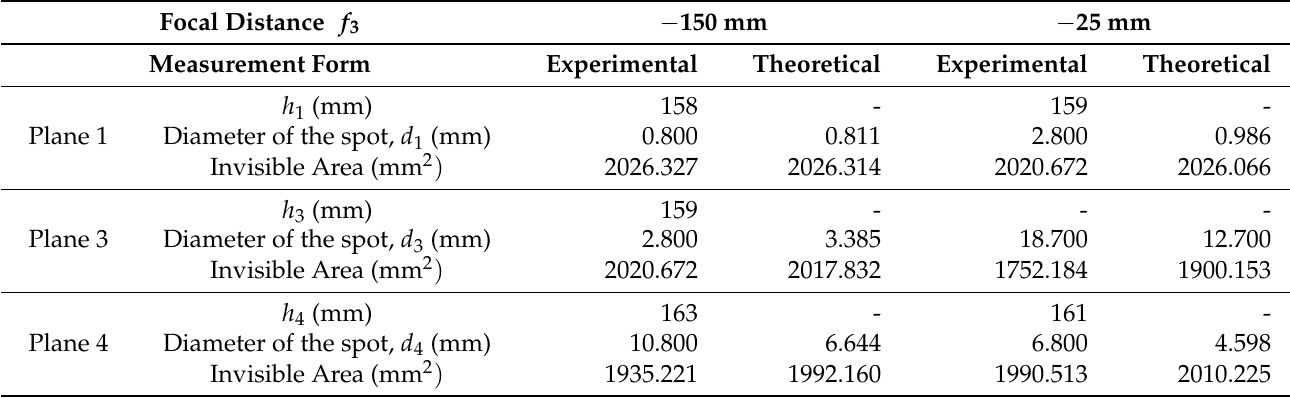
Figure 7. Photographs taken of the experimental system, in the cases when the object was invisible and when it was not, in the first zone for f 3 = − 25 mm. ( a ) Invisible object. ( b ) Height limit. The object begins to be visible. Table 1. Comparison between the theoretical and the experimental spot diameters and invisibility areas, for the two cases of interest ( f 3 = − 28 mm and f 3 = − 150